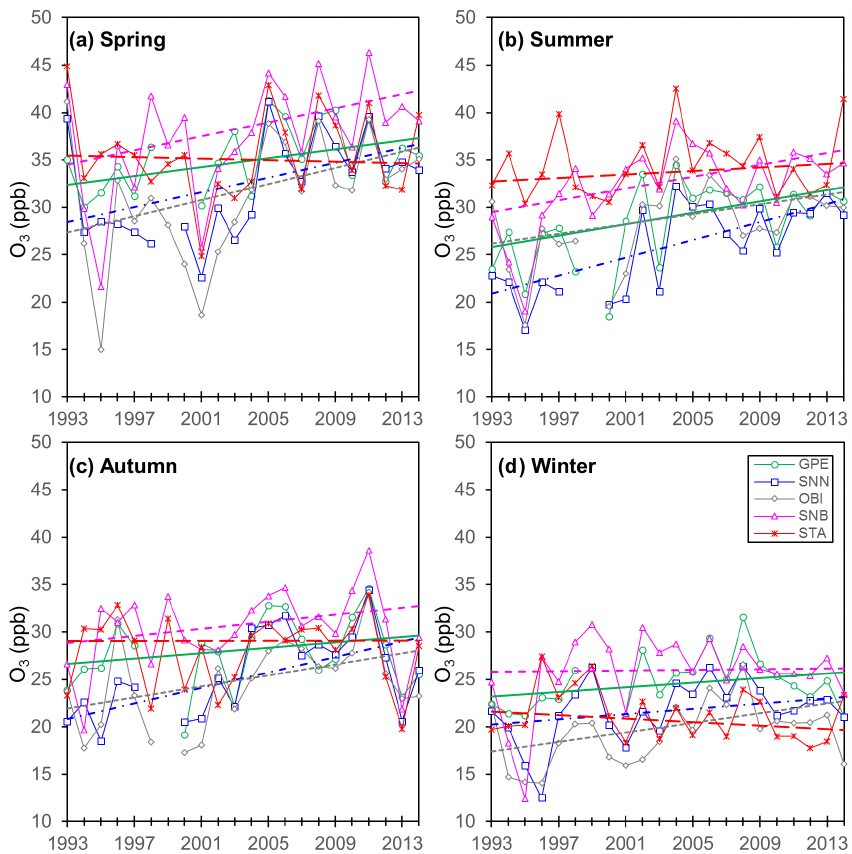
Figure 6. Seasonal trends in O 3 within the MMA during 1993–2014. Each data point represents the average of the 3-month period that defines the season. The continuous lines show the Sen